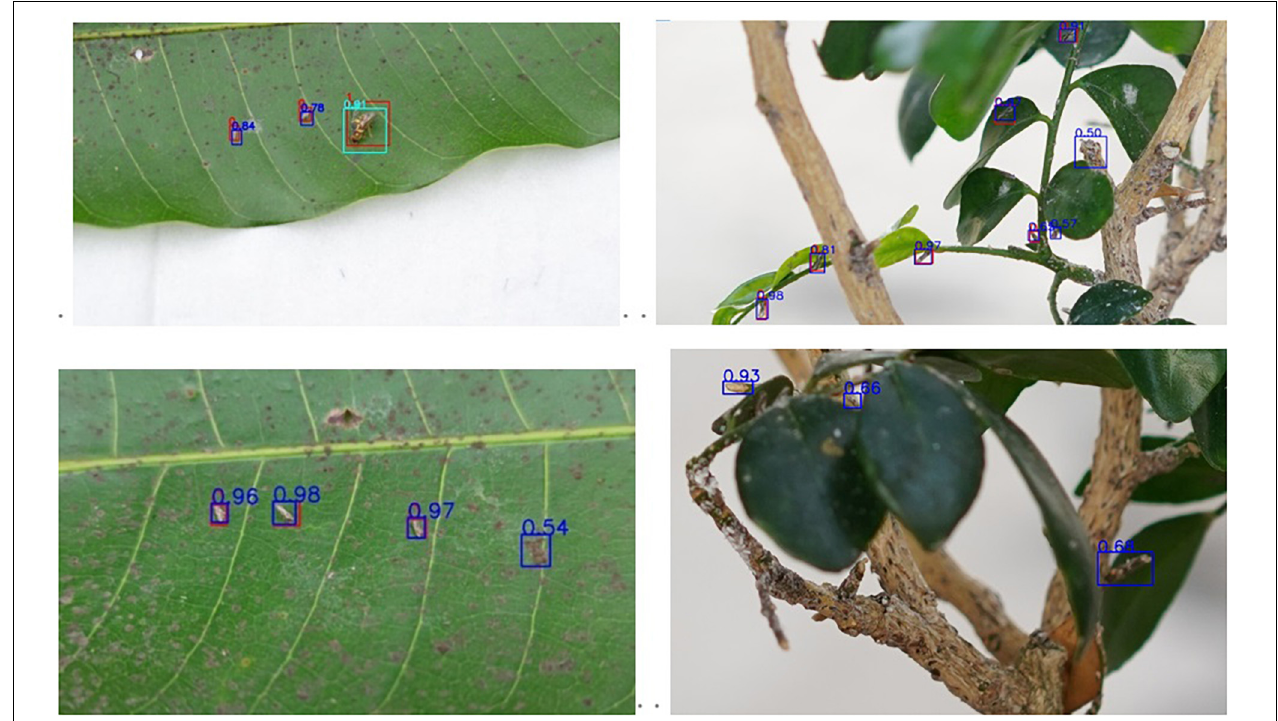
FIGURE 12 | Prediction